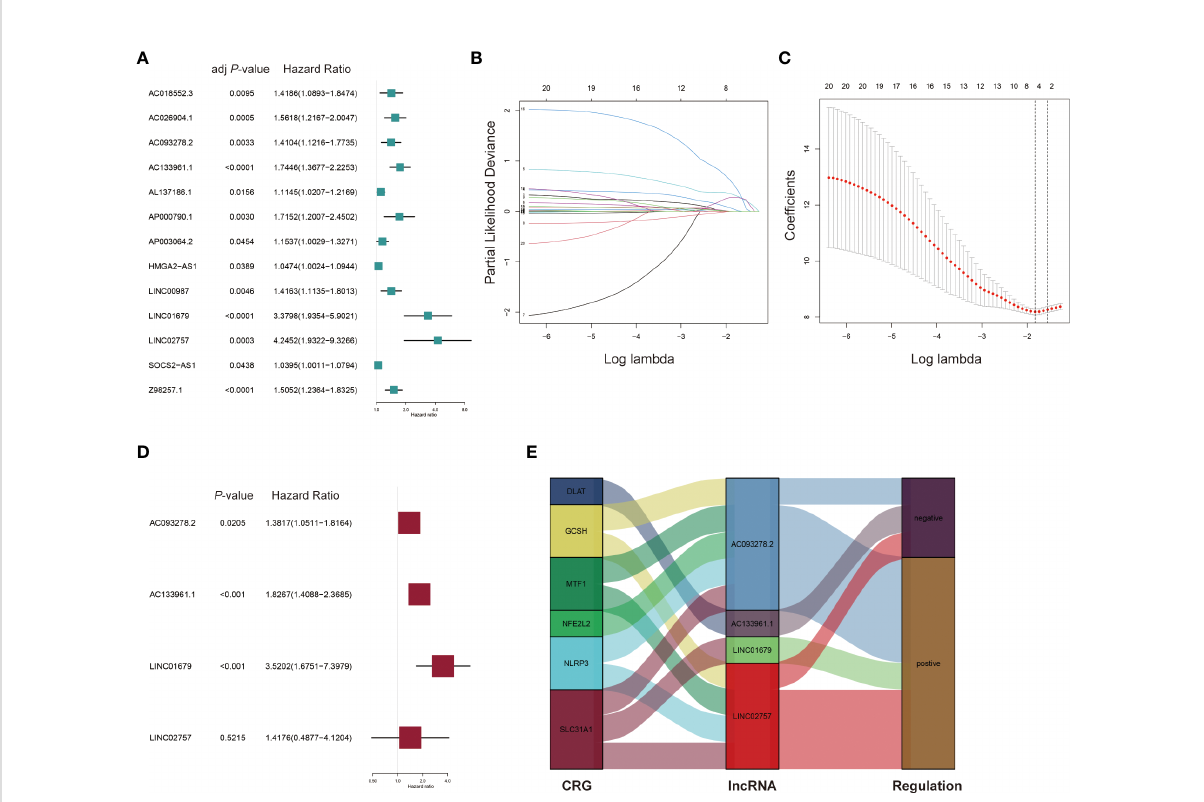
FIGURE 3 Construction of the prognostic cuproptosis-related lncRNA signature for AML patients in the training set. (A) Univariate Cox regression analysis for the prognostic cuproptosis-related lncRNAs. (B, C) Identi fi cation of prognostic cuproptosis-related lncRNAs in AML patients with 10-fold cross-validation for variable selection in LASSO (Least Absolute Shrinkage and Selection Operator) Cox regression. (D) Multivariate Cox regression analysis of the four cuproptosis-related lncRNAs for the prognosis of AML patients. (E) The Sankey diagram of cuproptosis-related genes (CRGs) and related